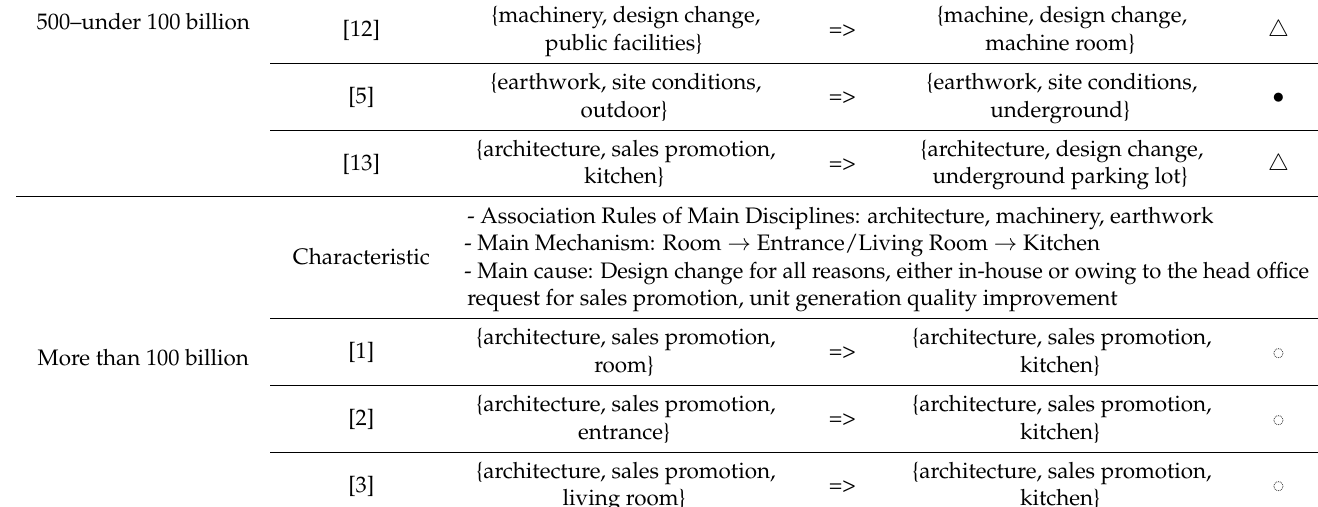
Table 3. Association rule classification system through expert interview.